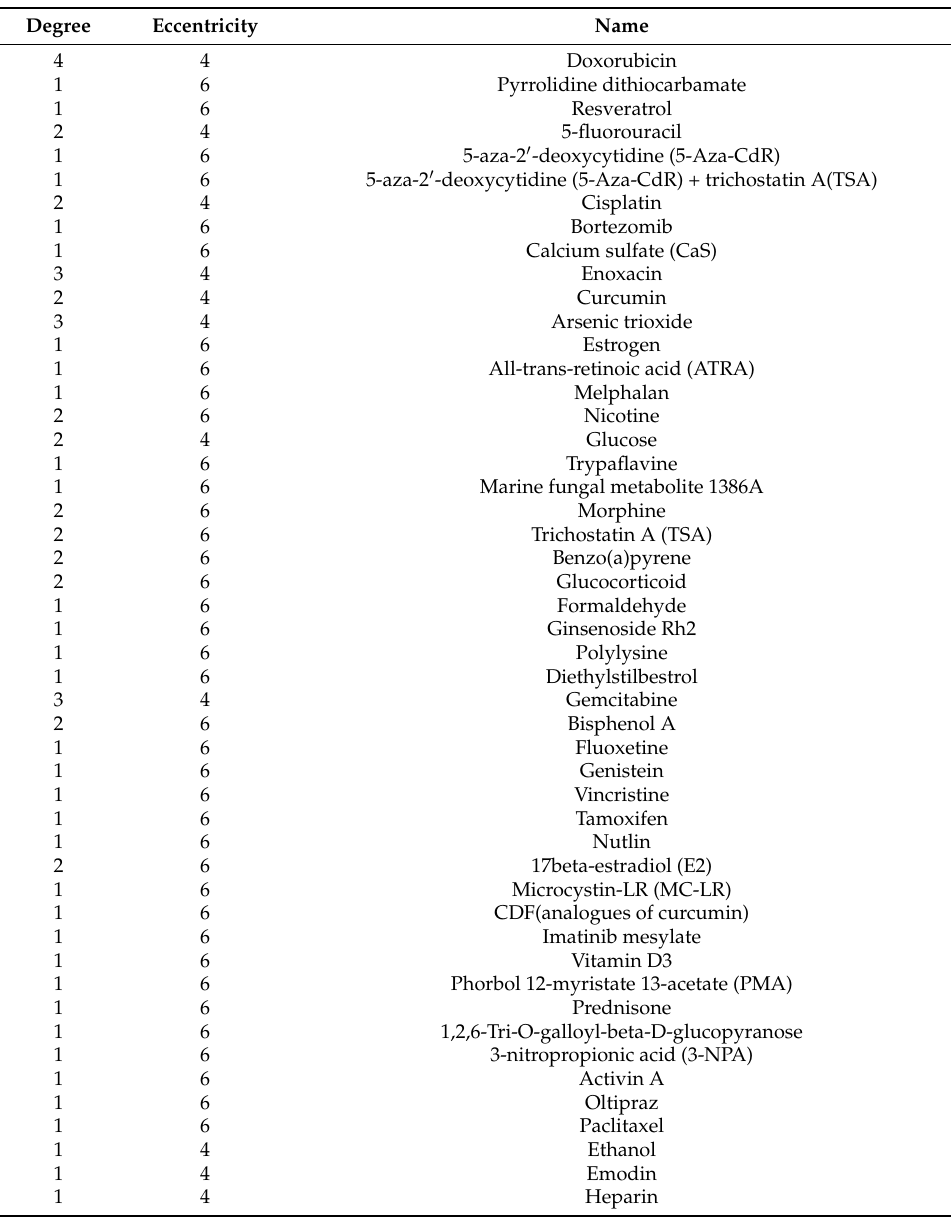
Table 2. Compounds able to modulate the expression of miR-199a, miR-16, miR-211, and miR-146a. Degree and eccentricity values (centrality metric parameters necessary for the identification of nodes important for network stability) were calculated by using Cytoscape Network Analysis. Degree: number of connections of each node with the others; eccentricity: the maximum distance from a node to any other node of the